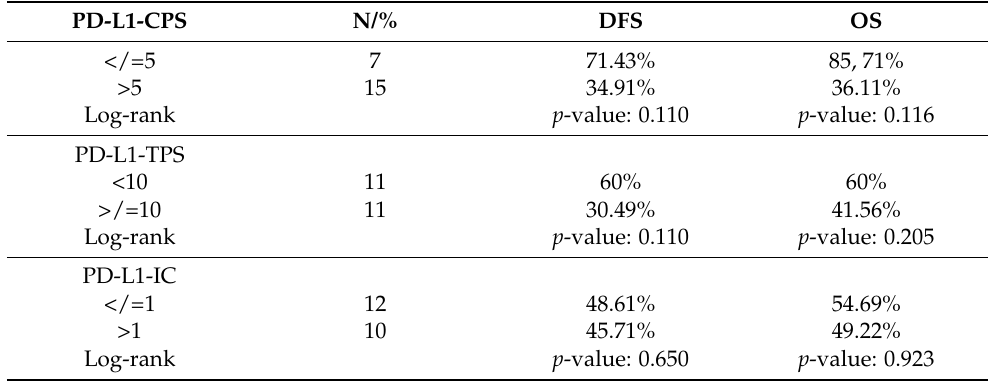
Table 4. Correlation of clinicopathological factors with immunohistochemistry. FIGO I versus FIGO II-IV